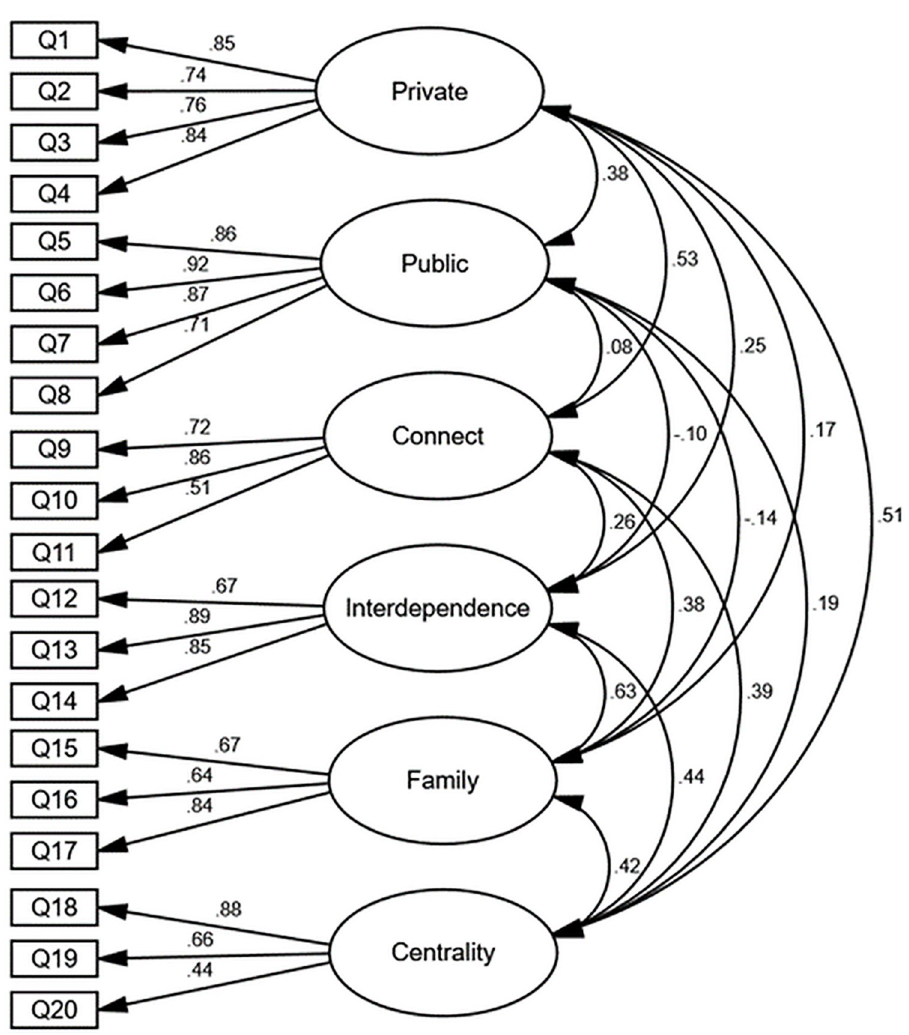
Fig 1. Revised 20-item six-factor Warrior Identity Scale (WIS-6) with standardised parameter estimates.